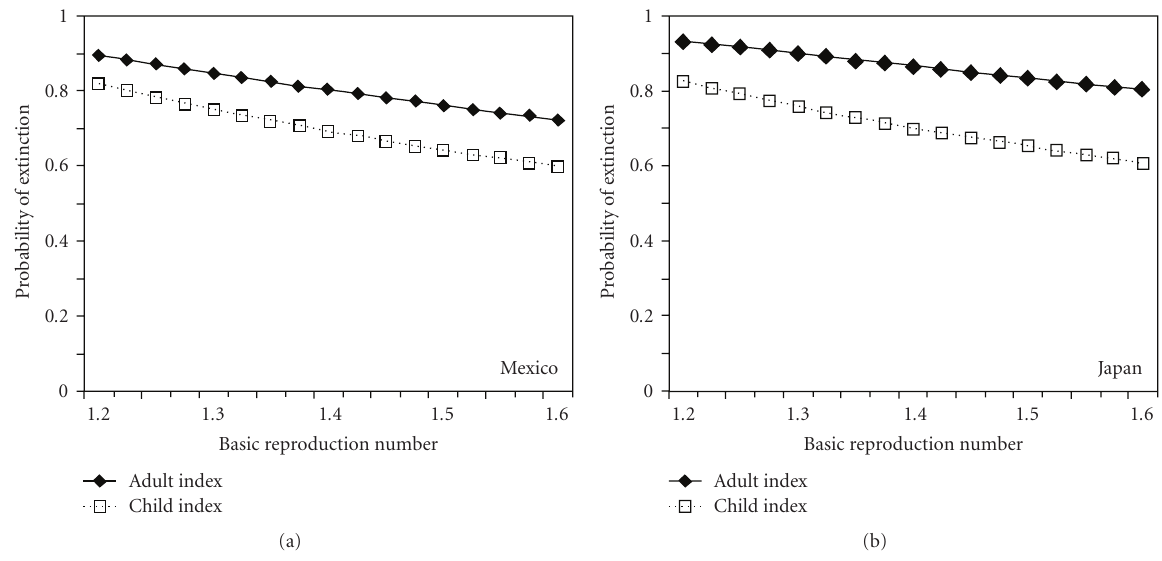
Figure 3: Probability of extinction given an introduction of single child or adult index case. The probabilities of extinction are calculated, assumingthat a single child or adult index case is introduced into a fully susceptible large population. The probability approximately accounts for heterogeneous transmissionamong and between child and adult populations. The estimates of the next-generation matrices are extracted from A. Fraser et al. [6] based on an analysis in Mexico and B. Nishiura et al. [2] in Japan. The basic reproduction numbers in the original studies in Mexico and Japan are estimated at R 0 = 1 . 58 and 1.22, respectively, and both panels rescales the next-generation matrix by multiplying each entry with R/R 0 where R measures the horizontal